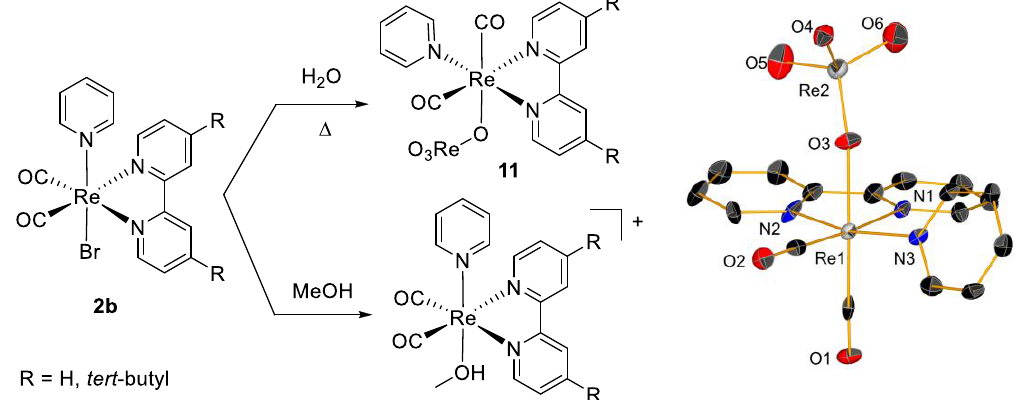
Figure 2. Solvated products from 2b in methanol and water leading, respectively, to the [Re(CO) 2 (bpy)(MeOH)(py)] + and [Re(CO) 2 (bpy)(ReO 4 )(py)] complexes. The ORTEP representation of crystal structure of 11 is shown to the right. Thermal ellipsoids are at 30% probability. Hydrogen atoms are omitted for clarity.